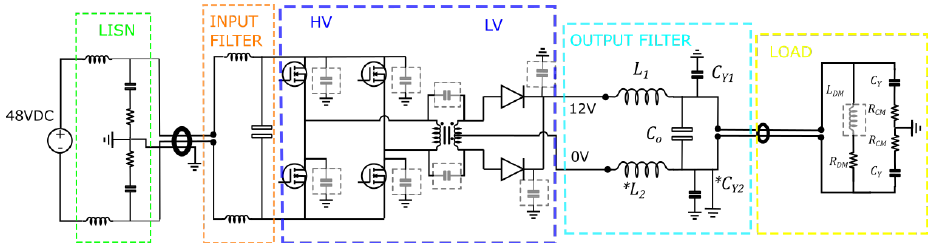
Figure 1. PSFB topology schematic. Paths that account for CM emissions are also represented. ∗ C Y 2 accounts either for a direct bonding connection or for a capacitive coupling to the converter grounded